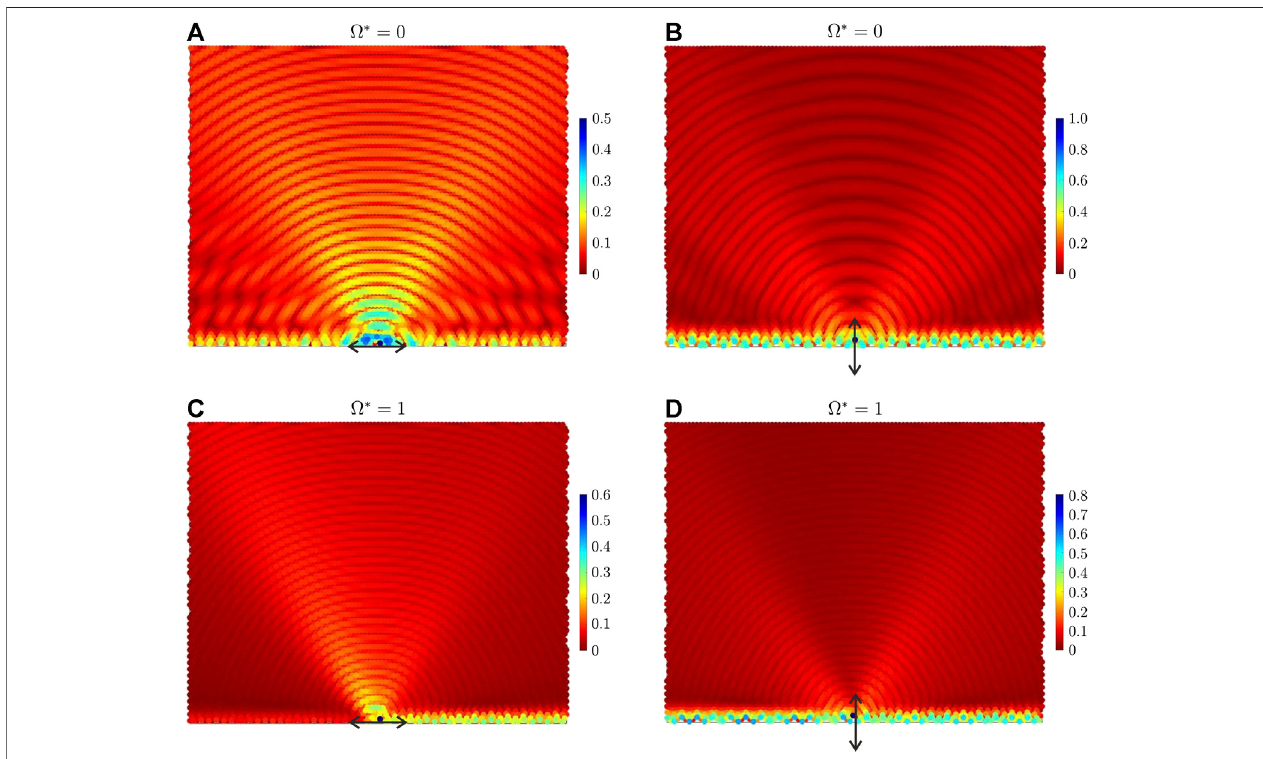
FIGURE 6 | Total displacement amplitude fi eld in the elastic lattice, obtained from the analytical formulation developed in Section 2 , due to a (A,C) horizontal and (B,D) vertical point force applied on the boundary. In each fi gure, the force is represented by an arrow. The effective gyricity is (A,B) Ω * (cid:1) 0 and (C,D) Ω * (cid:1) 1.